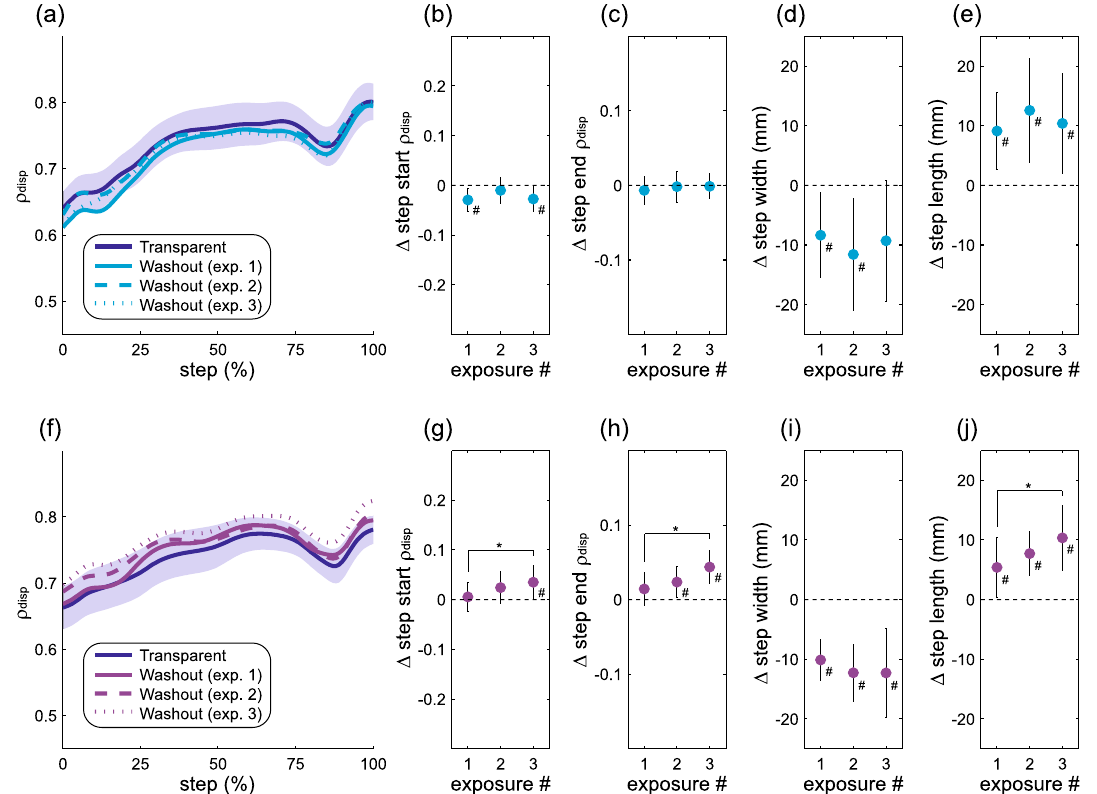
Figure 7. Gait behavior across the three washout periods. The top row ( a – e ) again illustrates gait metrics during the three washout periods following force-field assistance, while the bottom row ( f – j ) illustrates these metrics during washout periods following perturbations. The structure of the figure follows Fig. 5, with ρ disp representing the partial correlation between pelvis displacement and step width. For these comparisons, the first 225 steps of each exposure are